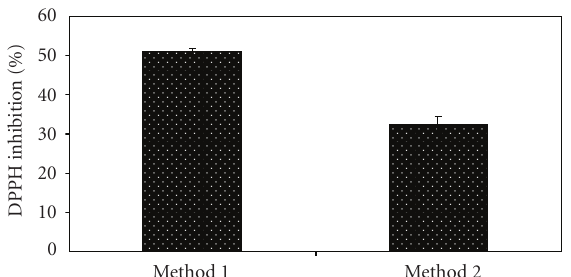
Figure 6: Comparison of the antiradical activity between the two methods of BHT extraction at the same plant growth